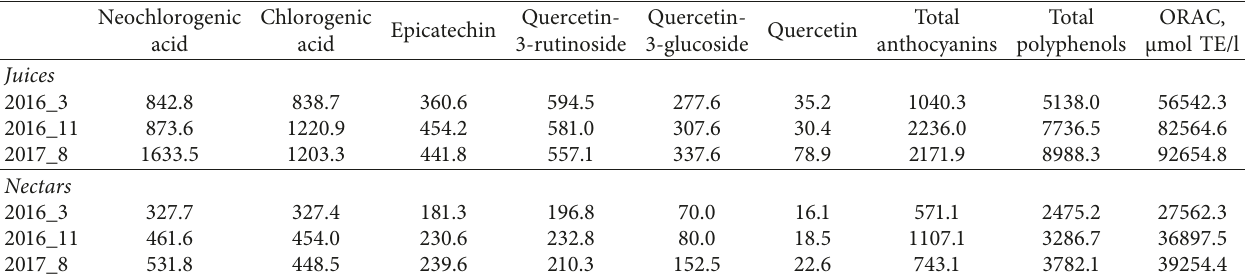
Table 5: Polyphenol content (mg/l) composition and antioxidant activity of aronia fruit juices and nectars obtained from different batches of aronia berries at 60˚C.